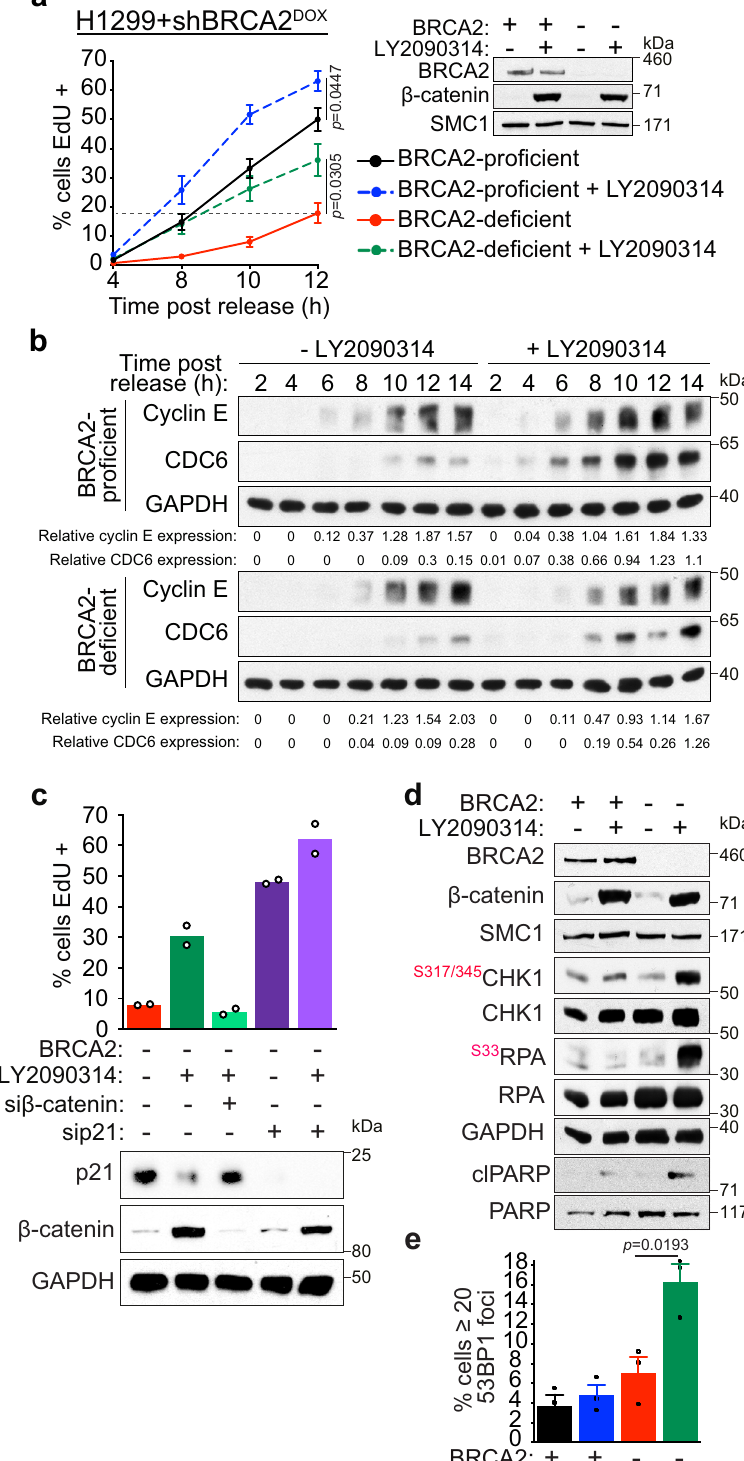
catenin-induced origins with respect to protein-coding genes. 20 h, we found that ∼ 52% of the β -catenin-induced origins fi red within genic regions, relative to ∼ 59% in BRCA2-pro fi cient cells (Fig. 5b). In BRCA1 − / − RPE1 cells released for 20 h, the